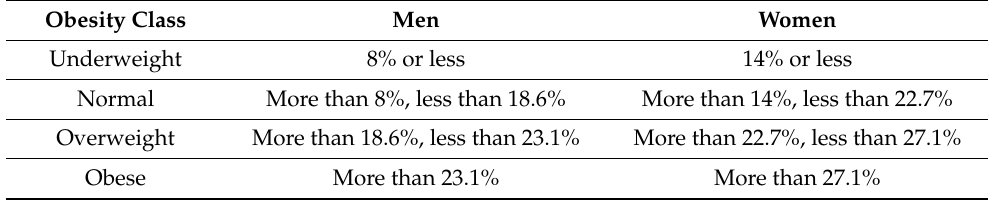
Table 2. Classification of obesity according to body fat percentage (total tissue %). Obesity